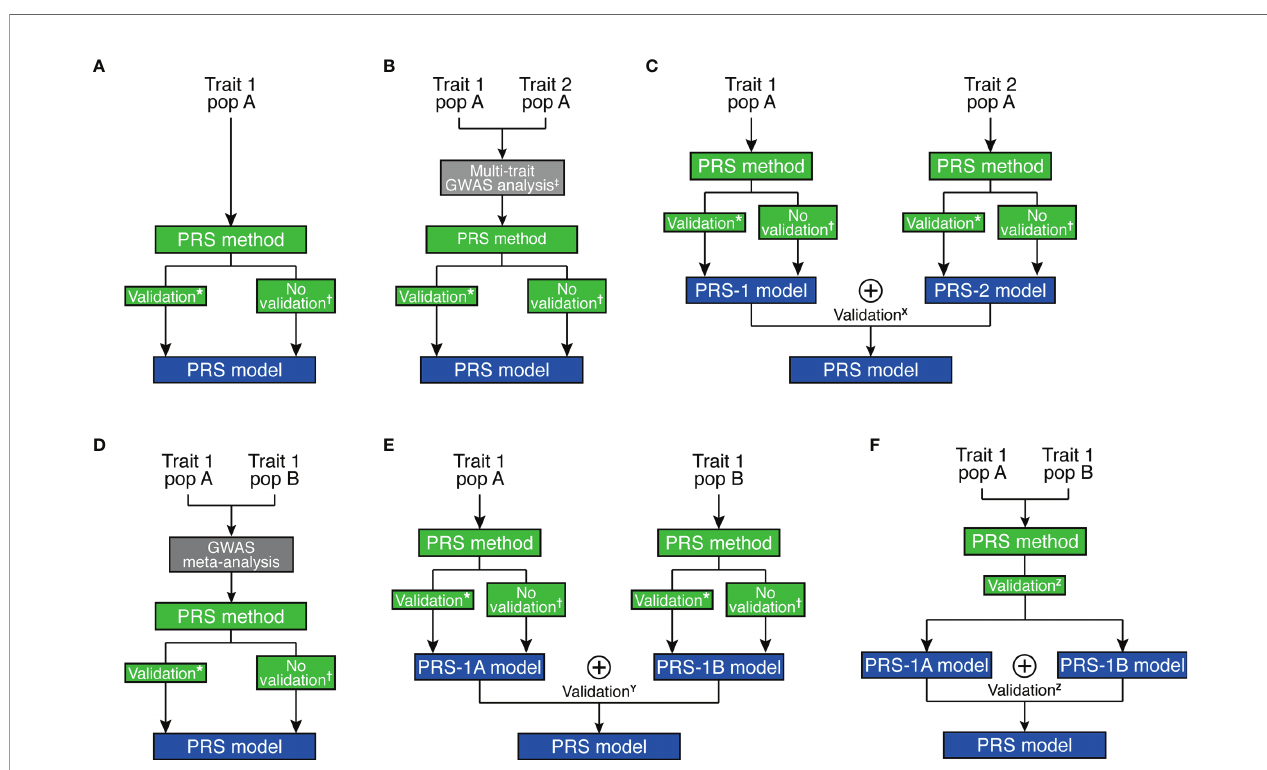
FIGURE 2 | Overview of strategies for polygenic risk score model development. (A) Single-trait and single-ancestry framework. (B) Multi-trait (at GWAS level) and single-ancestry framework. (C) Multi-trait (at PRS model level) and single-ancestry framework. (D) Single-trait and multi-ancestry (at GWAS level) framework. (E) Single-trait and multi- ancestry (at PRS model level) framework. (F) Single-trait and multi-ancestry (at both levels) framework. * Pruning and Thresholding, PRSice, Pruning and Thresholding with functionally-informed LASSO shrinkage, AnnoPred, BayesR, GBLUP, JAMPRED, LDpred/LDpred2, LDpred-funct, PRS-CS, LASSOSUM. † PUMAS, GCTA/SBLUP, GCTB/SBayesR, LDpred-inf, LDpred-funct-inf, PRS-CS-auto, LASSOSUM-pseudovalidation. ‡ MTAG, wMT-GWAS, Genomic SEM. X MPS, wMT-SBLUP. Y MultiPRS, PolyPred+. Z PRS-CSx. ⊕ represents the “ stacking ” method to combine different risk